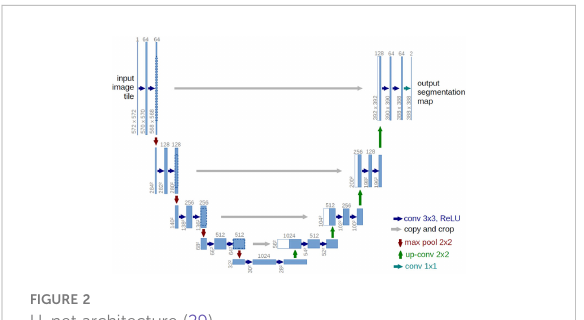
FIGURE 3 HarDNet network structure (27).